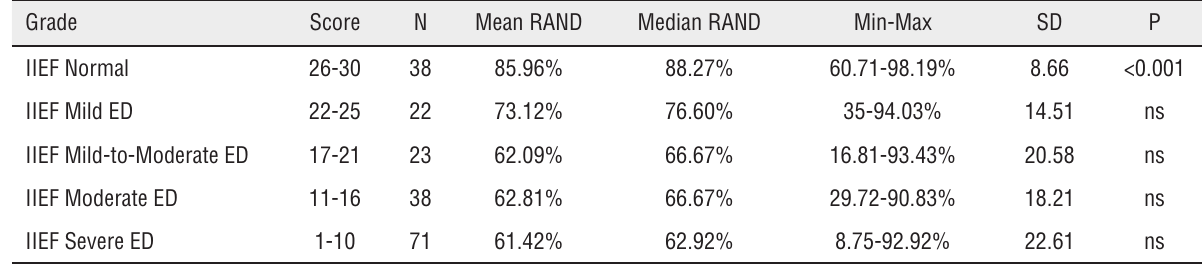
Table 6 - Correlation between RAND 36-Items Health Survey (RAND) and Erectile Dysfunction (ED) Grade According International Index of Erectile Function